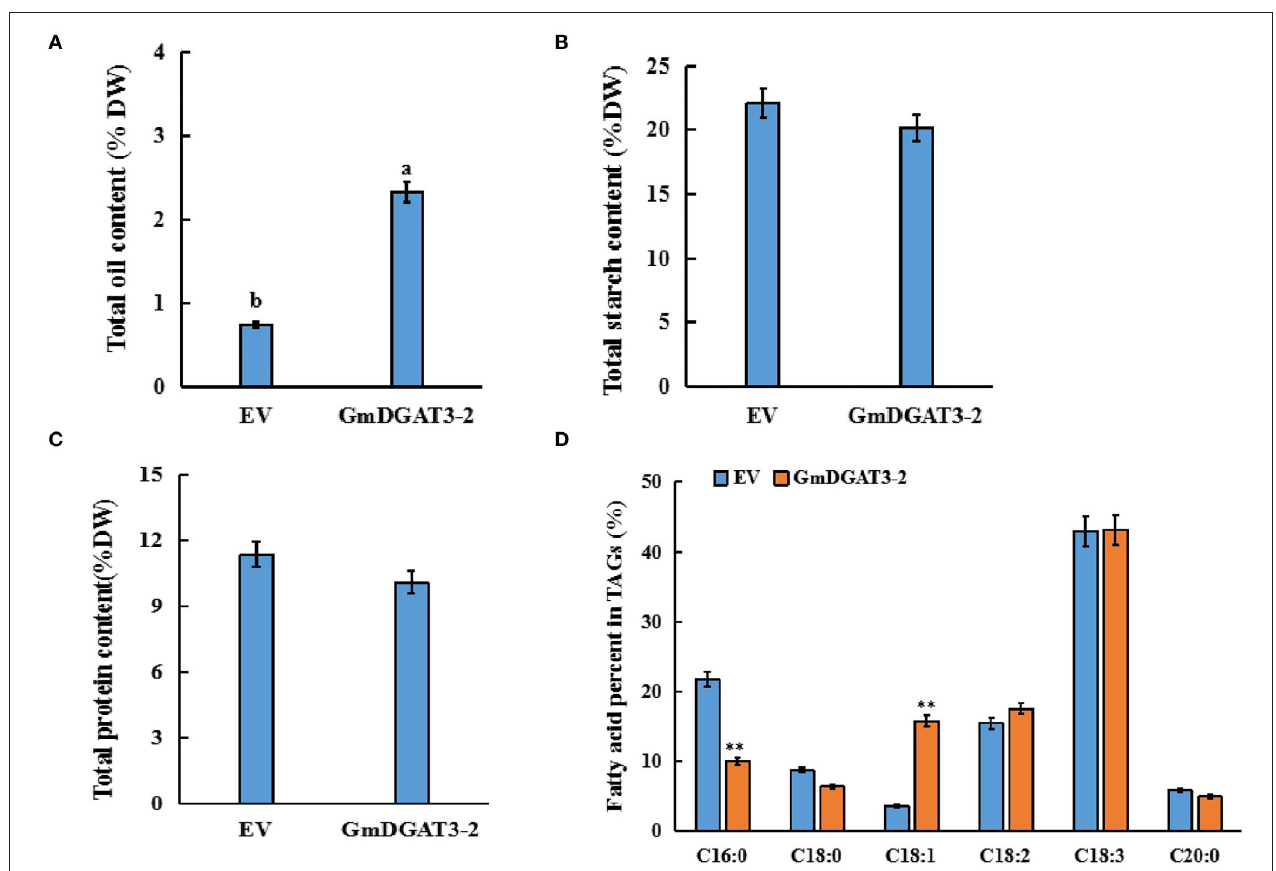
FIGURE 7 | Contents of total oil (A) , protein (B) , starch (C) , and fatty acid profiles (D) in tobacco leaves expressing GmDGAT3-2. EV, tobacco leaves transiently expressing empty vector (pCAMBIA1303). GmDGAT3-2, tobacco leaves expressing GmDGAT3-2 . The bars were SD s of three biological repeats. Lowercase letters indicate significant differences at the P < 0.05 level. Asterisks indicate significant difference from the EV according to t -test at ** P < 0.01, and * P < 0.05,